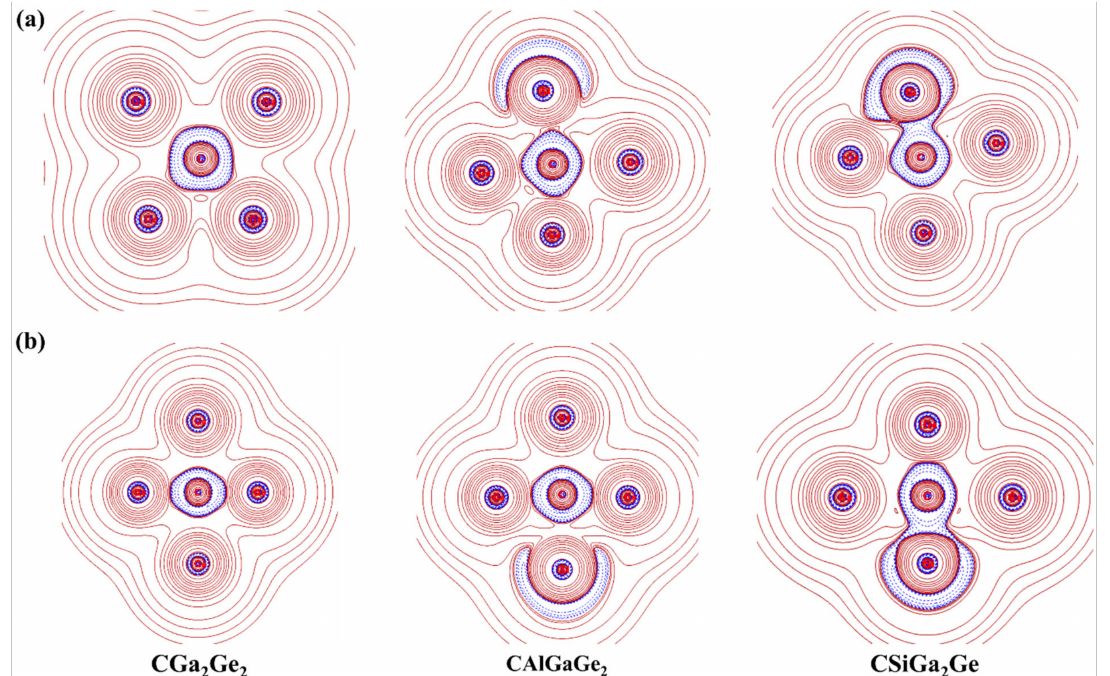
Figure 8. The plots of the Laplacian of electron density [ ∇ 2 ρ (r)], blue dashed and red solid lines indicate ∇ 2 ρ (r) < 0 and ∇ 2 ρ (r) > 0 regions, respectively, for ( a ) cis isomer; ( b ) trans isomer, for CGa 2 Ge 2 , CAlGaGe 2 , and CSiGa 2 Ge systems.